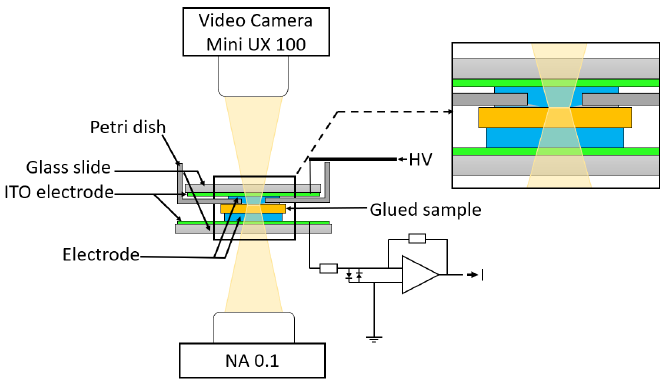
Figure 2. Scheme of the setup for domain switching with in situ optical domain imaging.